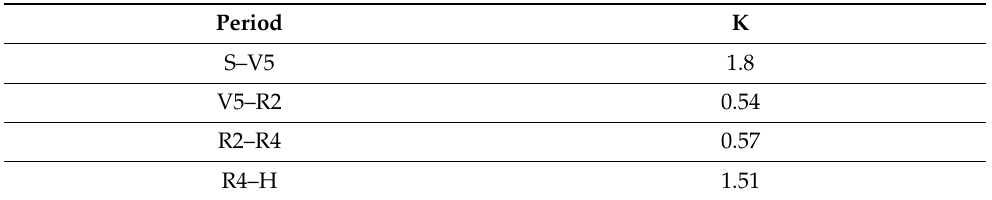
Figure 1. Daily precipitation for 2021 during maize vegetation. S—maize sowing date; V5—maize five leaves stage; R2—maize blister stage; R4—maize dough stage; H—maize harvest. Table 1. Hydrothermal coefficient for 2021 during maize vegetation. S—maize sowing date; V5— maize five leaves stage; R2—maize blister stage; R4—maize dough stage; H—maize